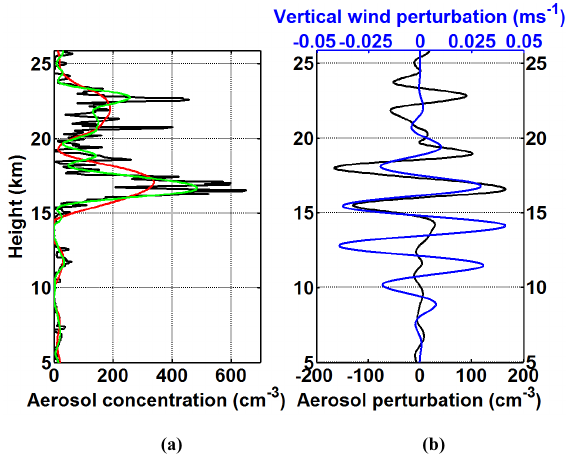
Figure 11. Vertical profiles of (a) aerosol concentration (cm − 3 ) and (b) aerosol (size class: 0.2–50µm) perturbations with 1.6– 3.2km vertical wavelengths and simulated vertical wind perturba- tions (ms − 1 ) on 27 July at 23:03UTC. On left panel, black (red) solid line corresponds to raw (background) profile (cm − 3 ) . The sum of the background profile and GW-induced perturbations is drawn as a green solid